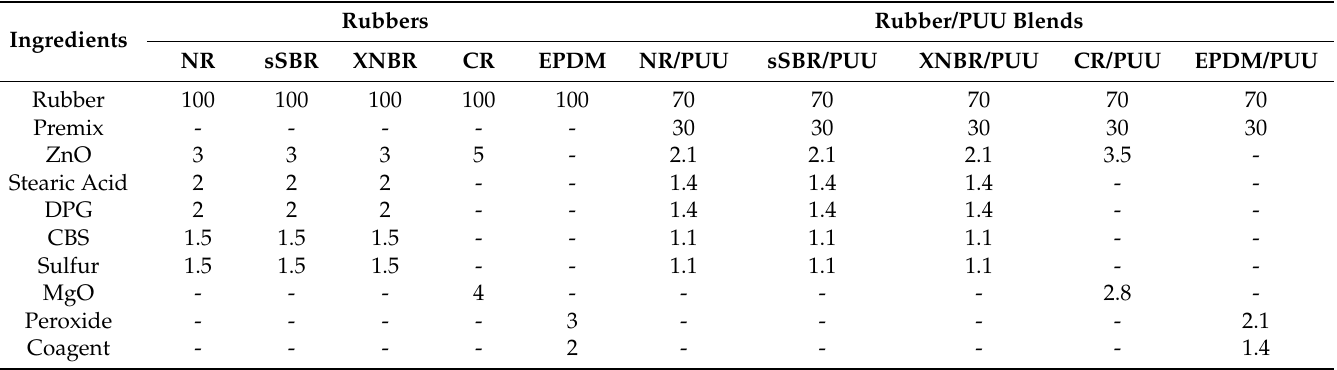
Table 1. Formulation of compounds in weight parts per hundred parts of rubber